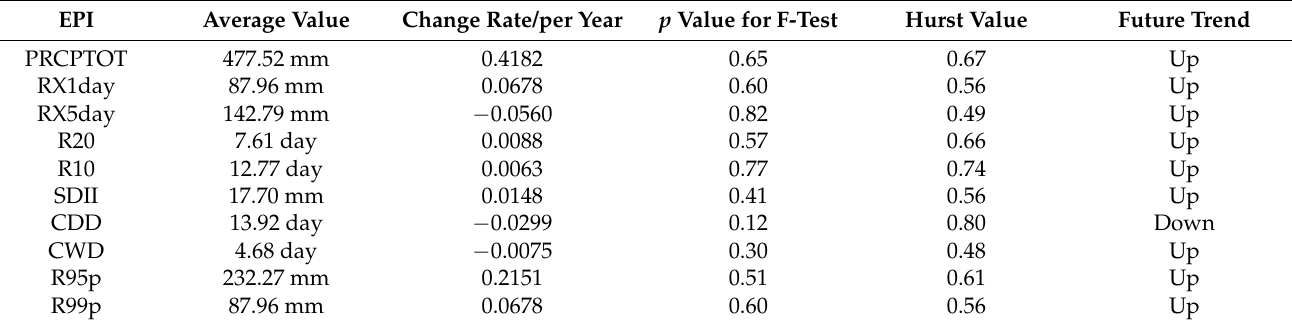
Table 5. Statistic of change trend of each EPI within Hubei province in summer during 1960 – 2019.